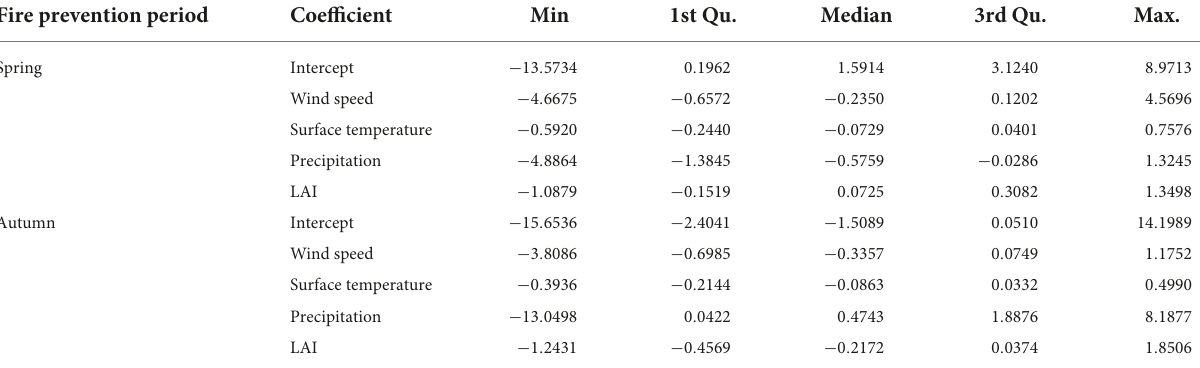
TABLE 4 Parameter estimation of the geographically weighted logistic regression (GWLR)